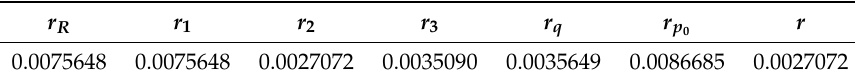
Table 4. Different values of parameters which satisfy Theorem 1.